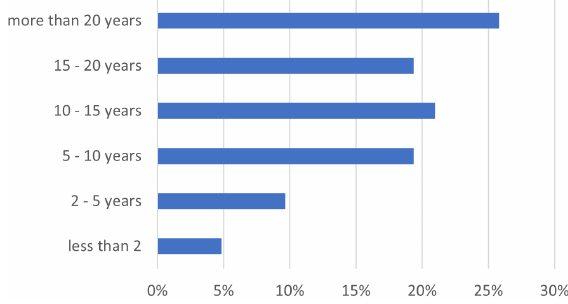
Figure 2. Work experience of respondents (based on 62 responses).